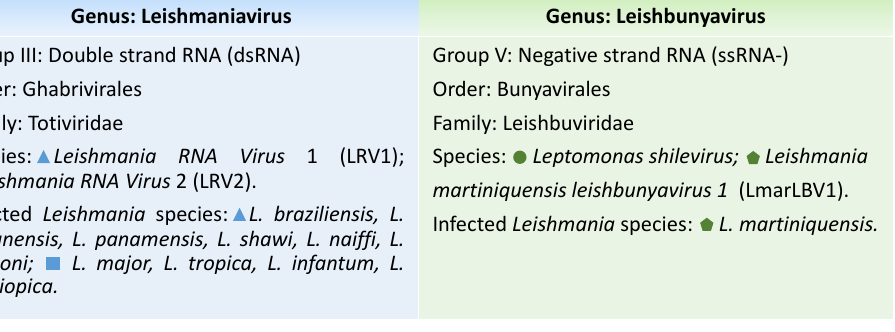
Figure 1. Classification of Leishmaniavirus and Leishbunyavirus viruses and Leishmania species de- scribed so far harbouring each of these